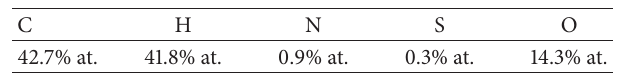
Table 2: Average adsorption efficiencies for single Cu 2+ ions and